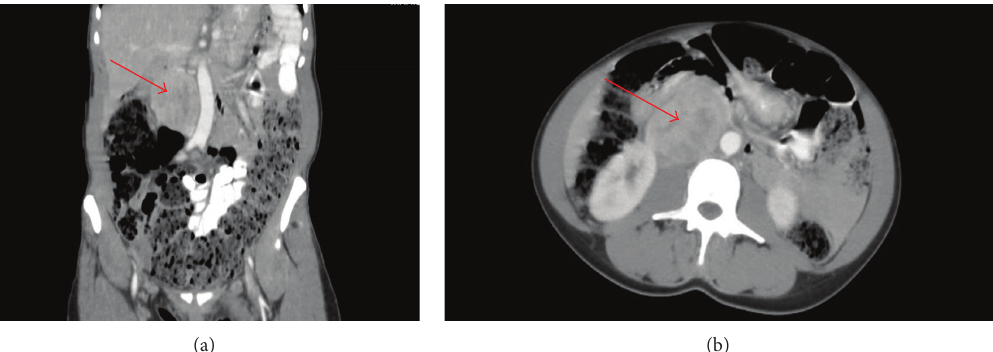
Figure 1: Paraganglioma (red arrow) visualized on computed tomography scan with IV contrast in coronal (a) and axial (b) planes without definitive evidence of local invasion.